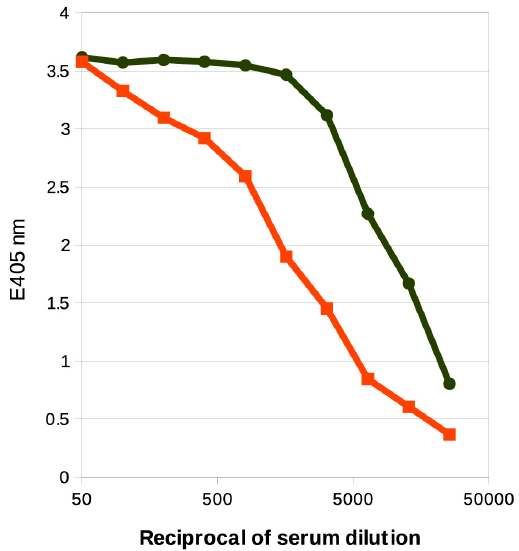
Figure 5. ELISA profiles of polyclonal antibodies specific for the P. shigelloides serotype O12 with LPSs of P. shigelloides 78/89 (black line) and K. pneumoniae Kp20 (red line) as solid-phase antigens (10 µg/mL). The depicted ELISA values are the means of four replicates.